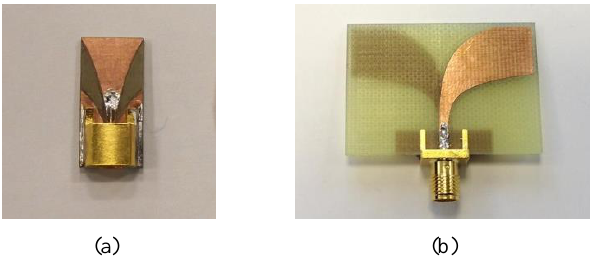
Figure 1: (a) The miniature UWB antenna and (b) the Vivaldi antenna used for the transmitter and receiver nodes respectively.